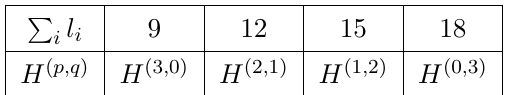
Table 1 . Correspondence between harmonic 3-forms and RR ground states for our LG